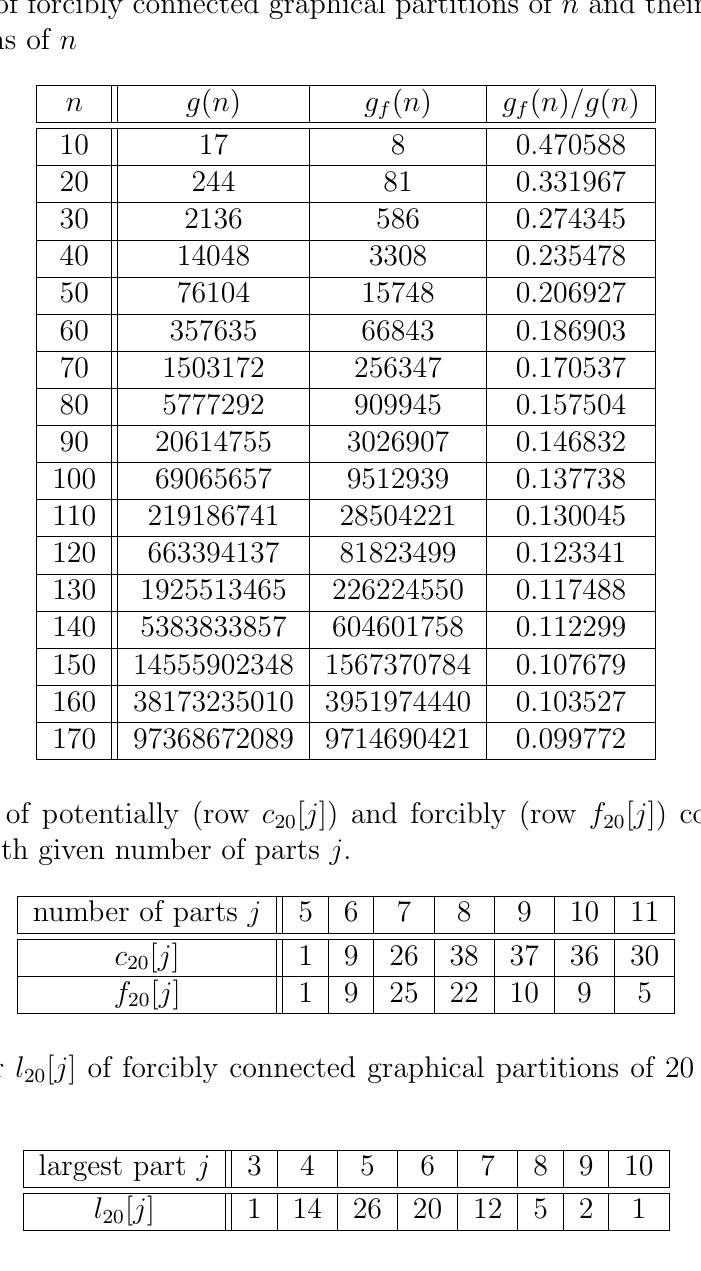
Theory and Applications of Graphs, Vol. 5 [2018], Iss. 2, Art.